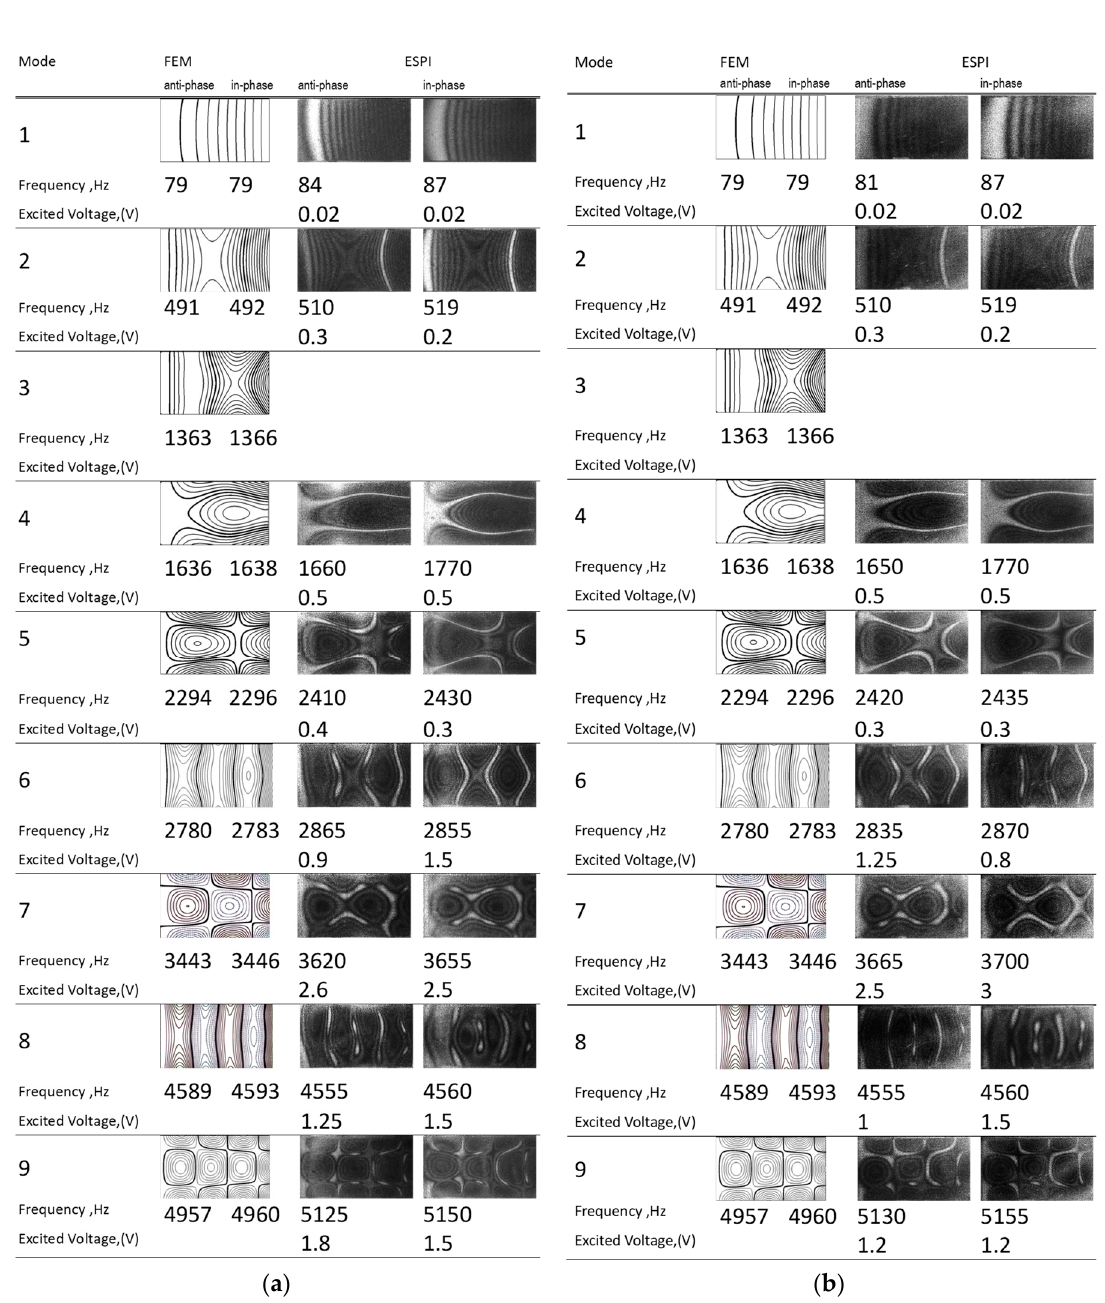
Figure 8. AF-ESPI and FEM results obtained from pumping element coupled with air ( a ) upper and ( b ) lower piezoelectric plate.